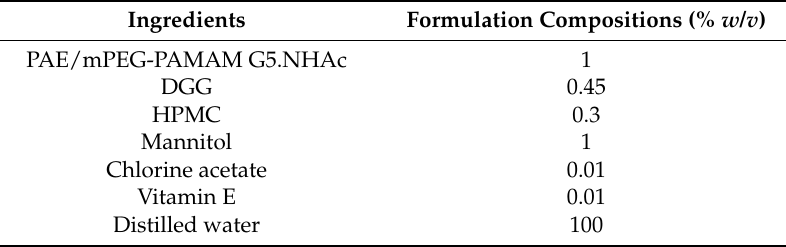
Table 5. Compositions of in situ